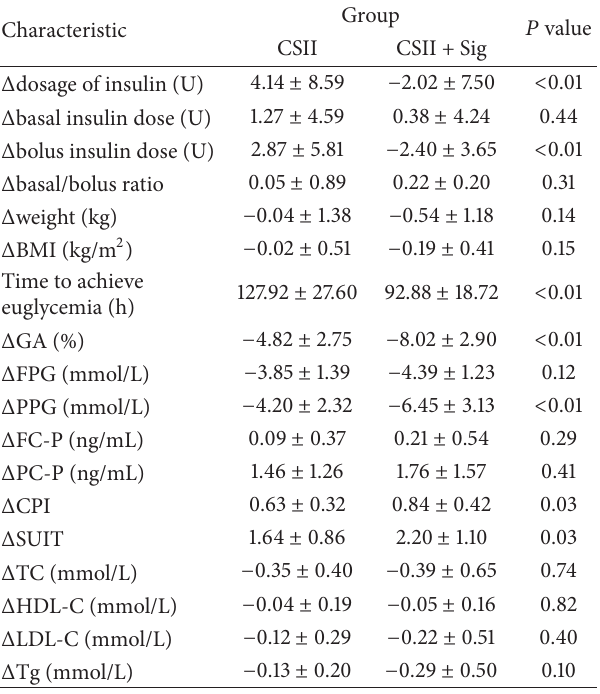
Table3:Comparisonofthechangesinininsulindosageandclinical features from before to after treatment between the CSII and CSII + Sig